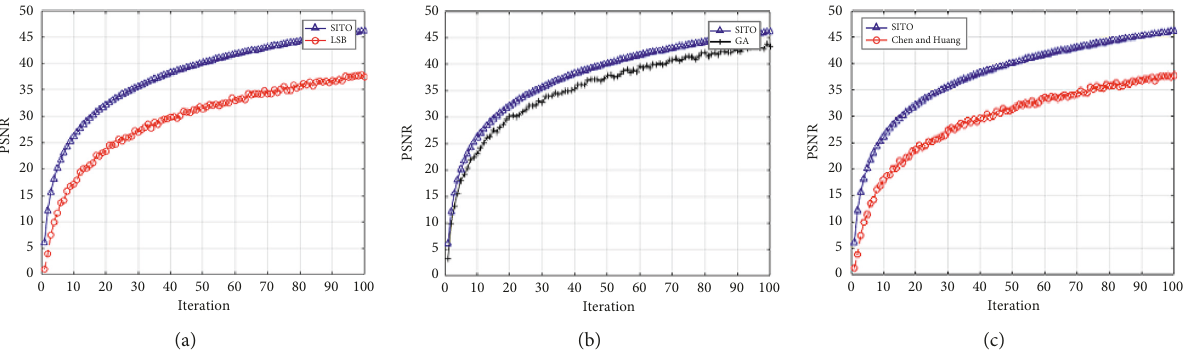
Figure 7: Comparison of PSNR variation with (a) LSB, (b) GA, and (c) the method of Chen and Huang [1].